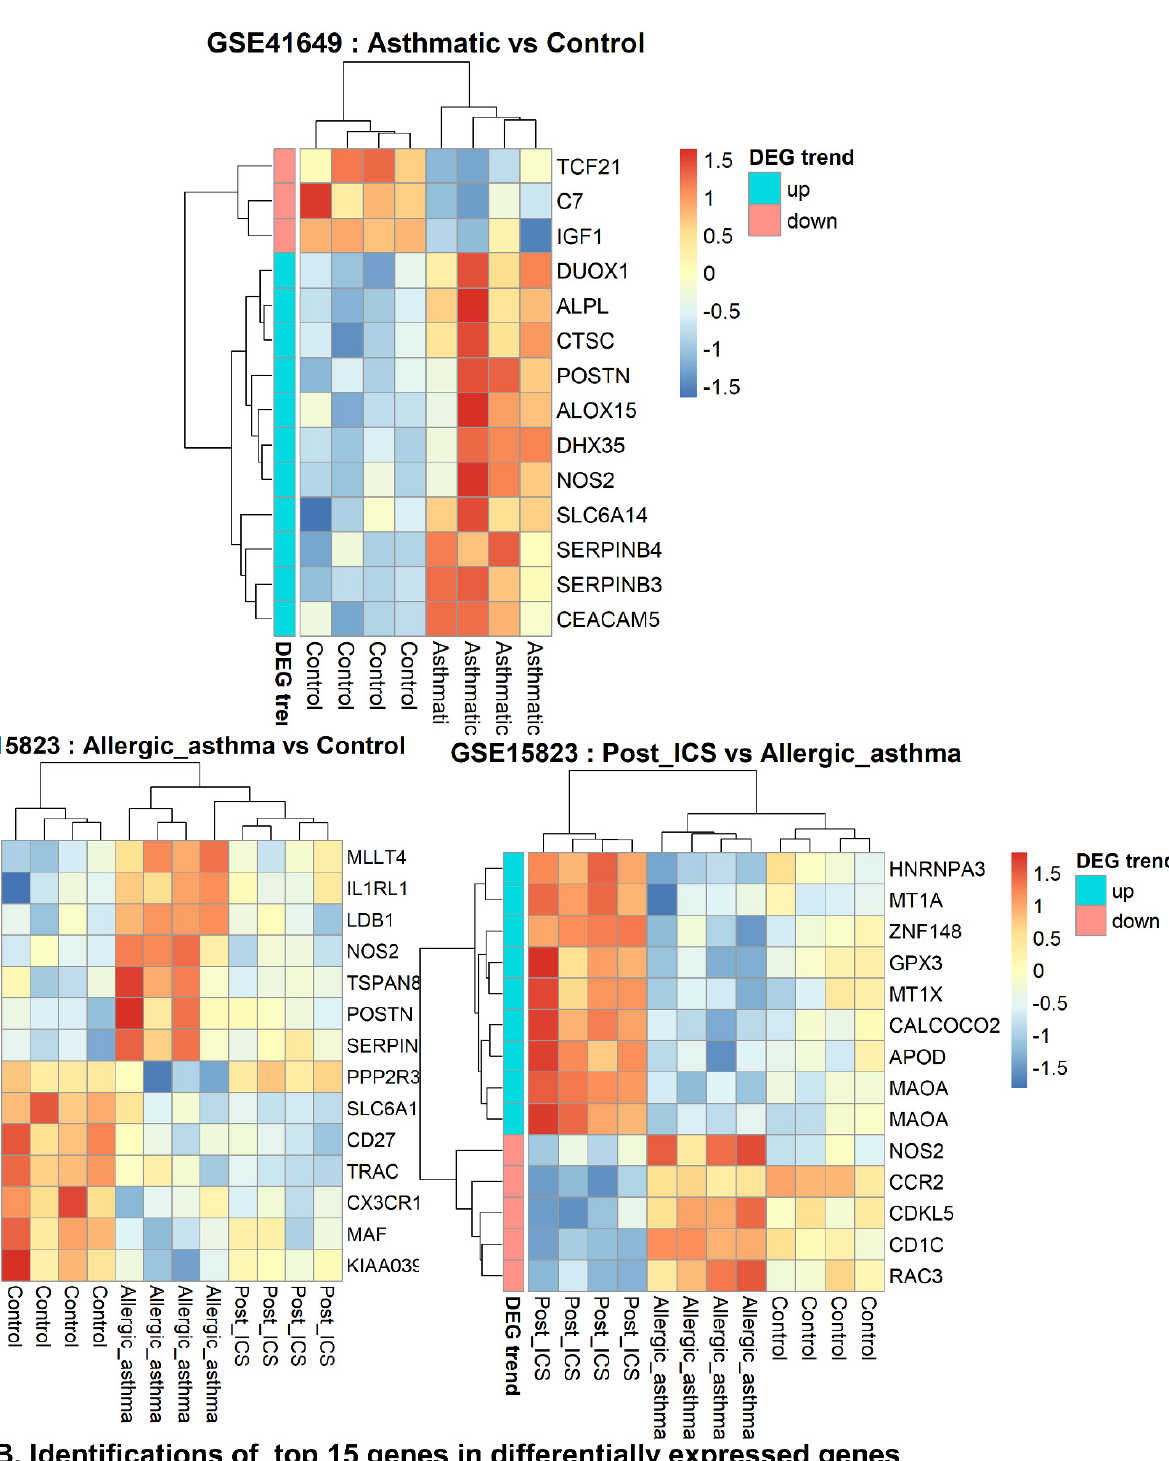
Figure 4. Contrast–dependent identification of differentially expressed genes (DEGs) of GSE41649 and GSE41649. ( A ) DEG volcano plots of datasets. ( B ) Top 15 DEGs of datasets. Contrasts: GSE41649: Asthma vs. control, GSE15283: Asthma vs. control, Post–ICS vs.